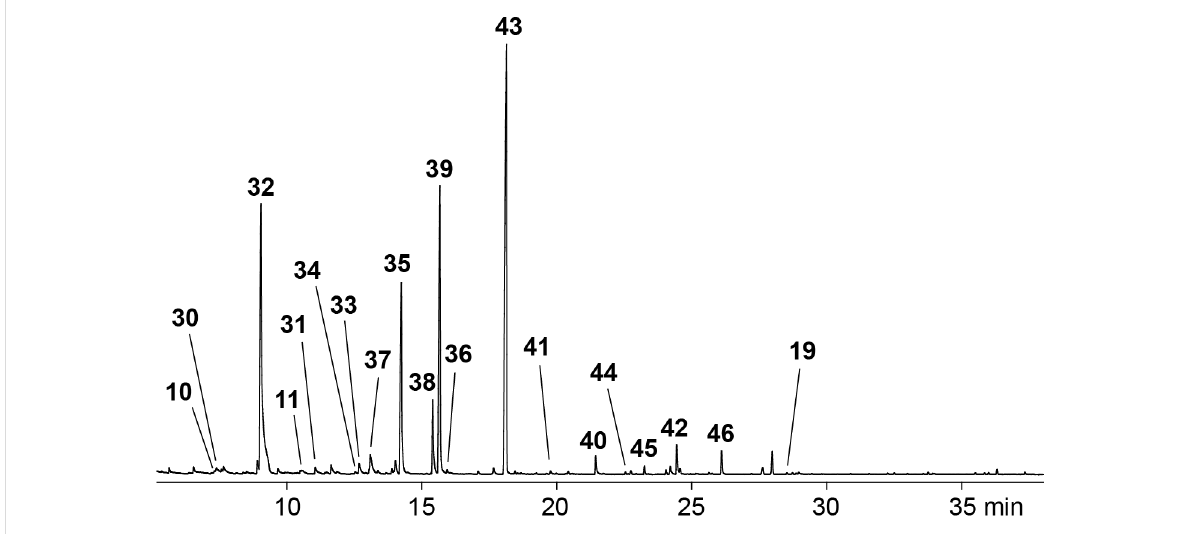
Figure 6: Total ion chromatogram of a CLSA headspace extract from Hypoxylon macrocarpum STMA 130423. Peak numbers refer to compound numbers in Table 5 and in Figure 7.